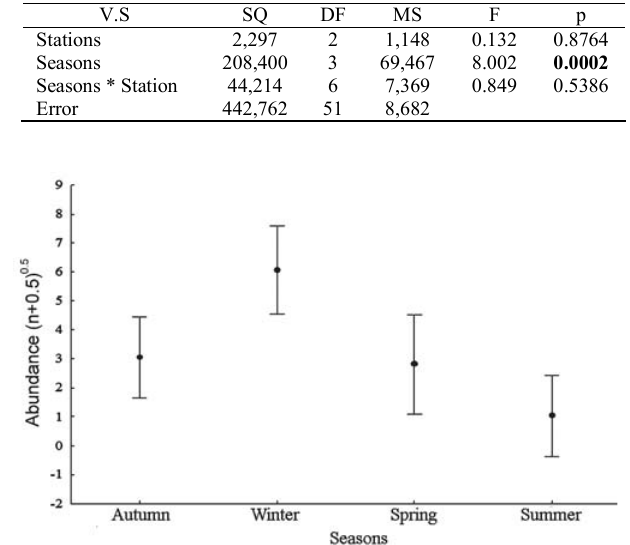
Fig. 2. Adjusted average of number of Isopisthus parvipinnis individuals captured over the seasons on coast of Ilhéus, Bahia, Brazil.